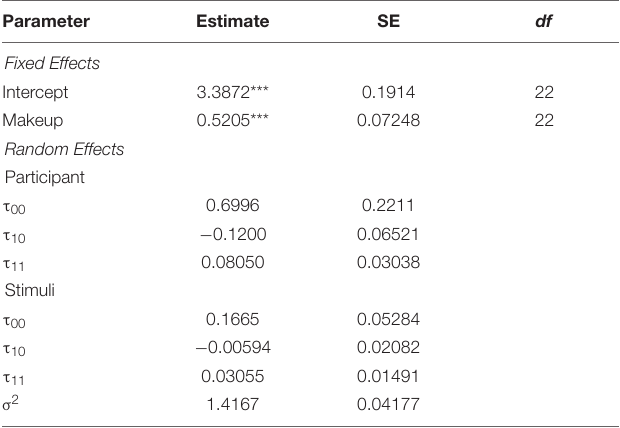
TABLE 3 | Parameter estimates for multilevel model predicting Sociosexuality ratings from Makeup